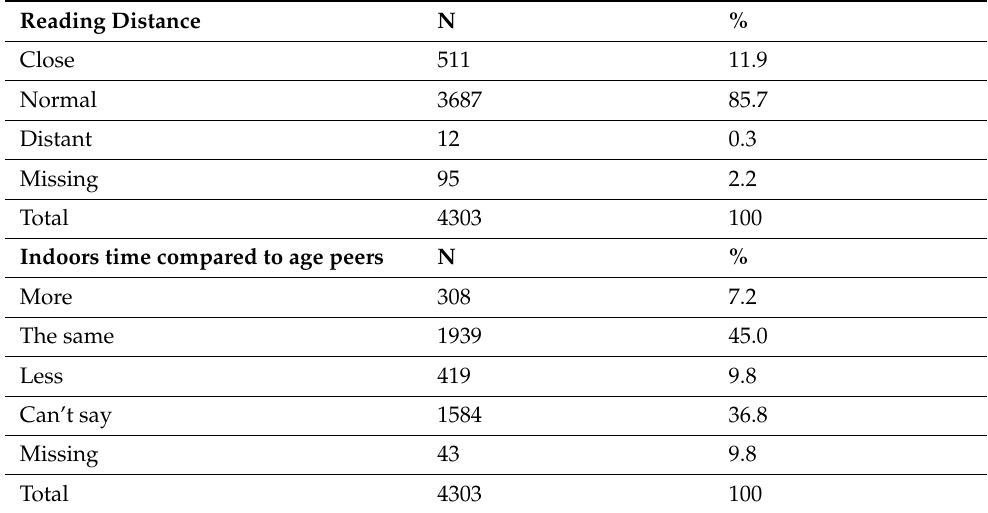
Table 2. Distribution of parent’s estimates of their child’s reading distance and indoors time compared to age